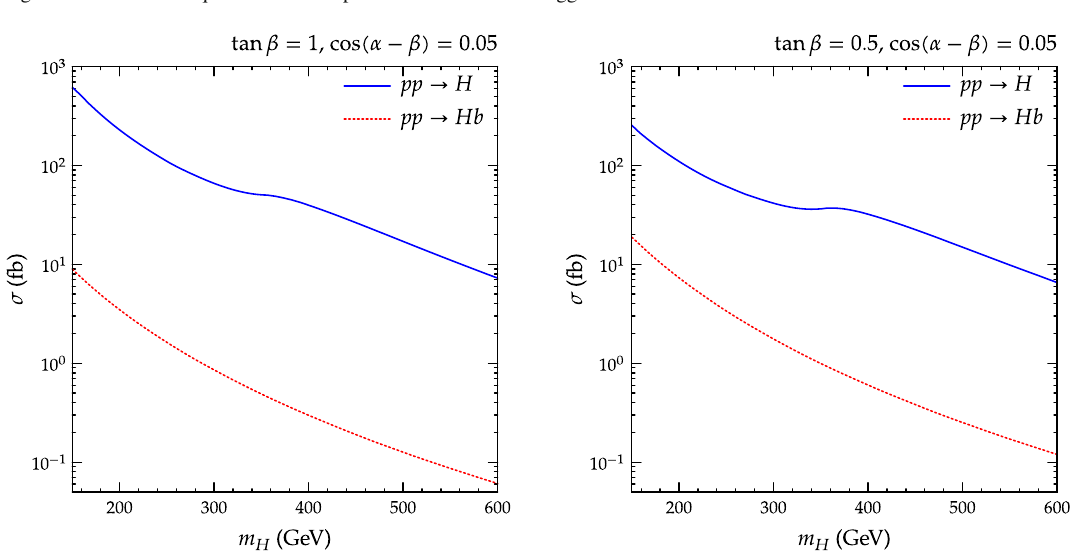
Fig. 8 Production cross sections of the heavy neutral Higgs H at 14 TeV proton-proton collisions. We have chosen tan β = 1 (left panel) and tan β = 0 . 5 (right panel) with cos (α − β) = 0 . 05 and y u